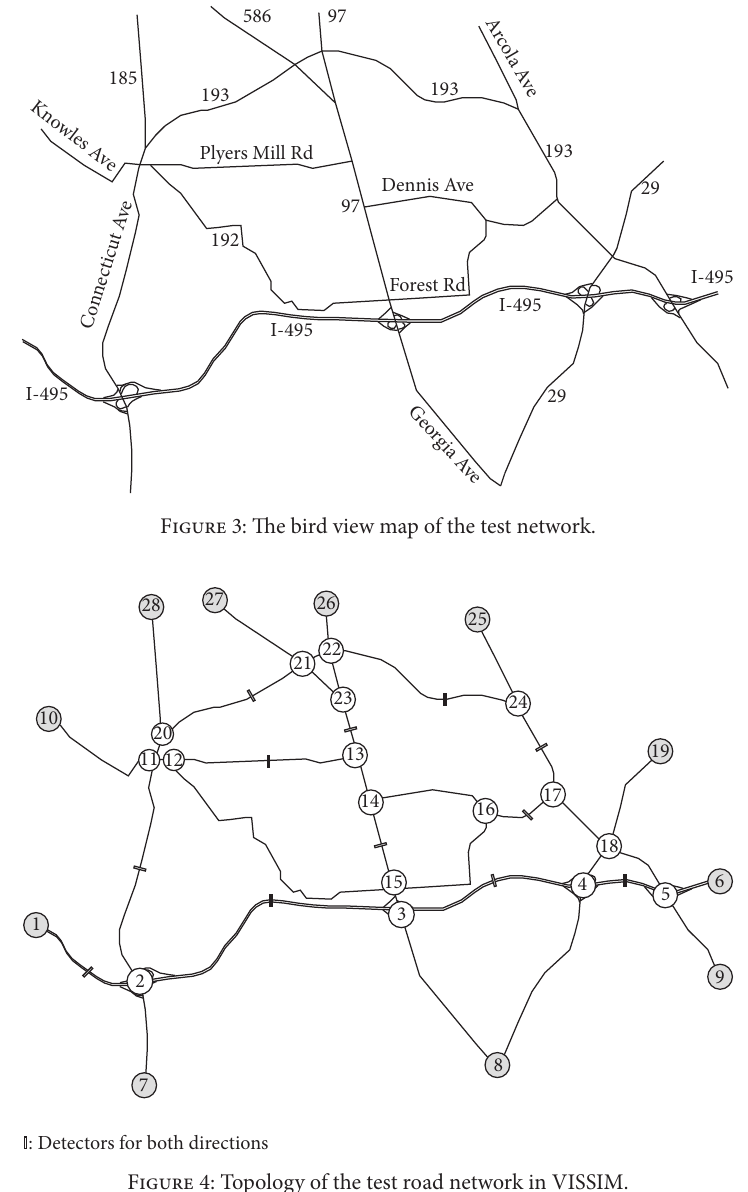
Figure 4: Topology of the test road network in